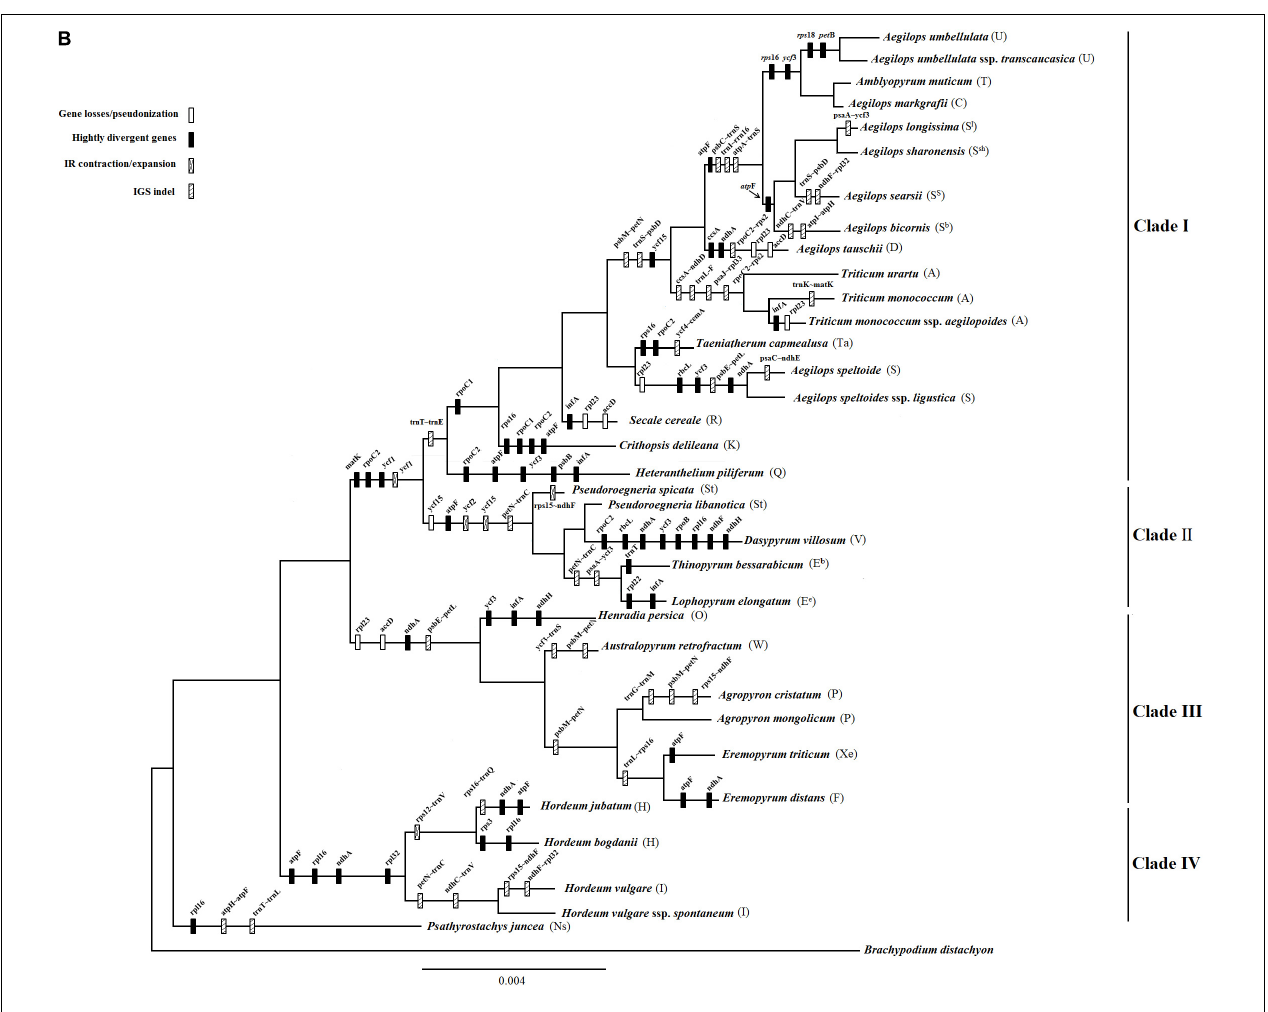
FIGURE 1 | Maximum-likelihood tree inferred from whole complete chloroplast (cp) genome sequences for the diploid Triticeae using RAxML v.8.2.10. (A) Phylogenetic tree topology with bootstrap support (BS) above and posterior probabilities (PP) below branches ( > 50% BS; > 0.9 PP). (B) Gene loss/pseudonization, indels in protein coding genes, intron variation, and intergenic sequence (IGS) indels within the cp genomes were characterized and mapped on the branches of the phylogenetic